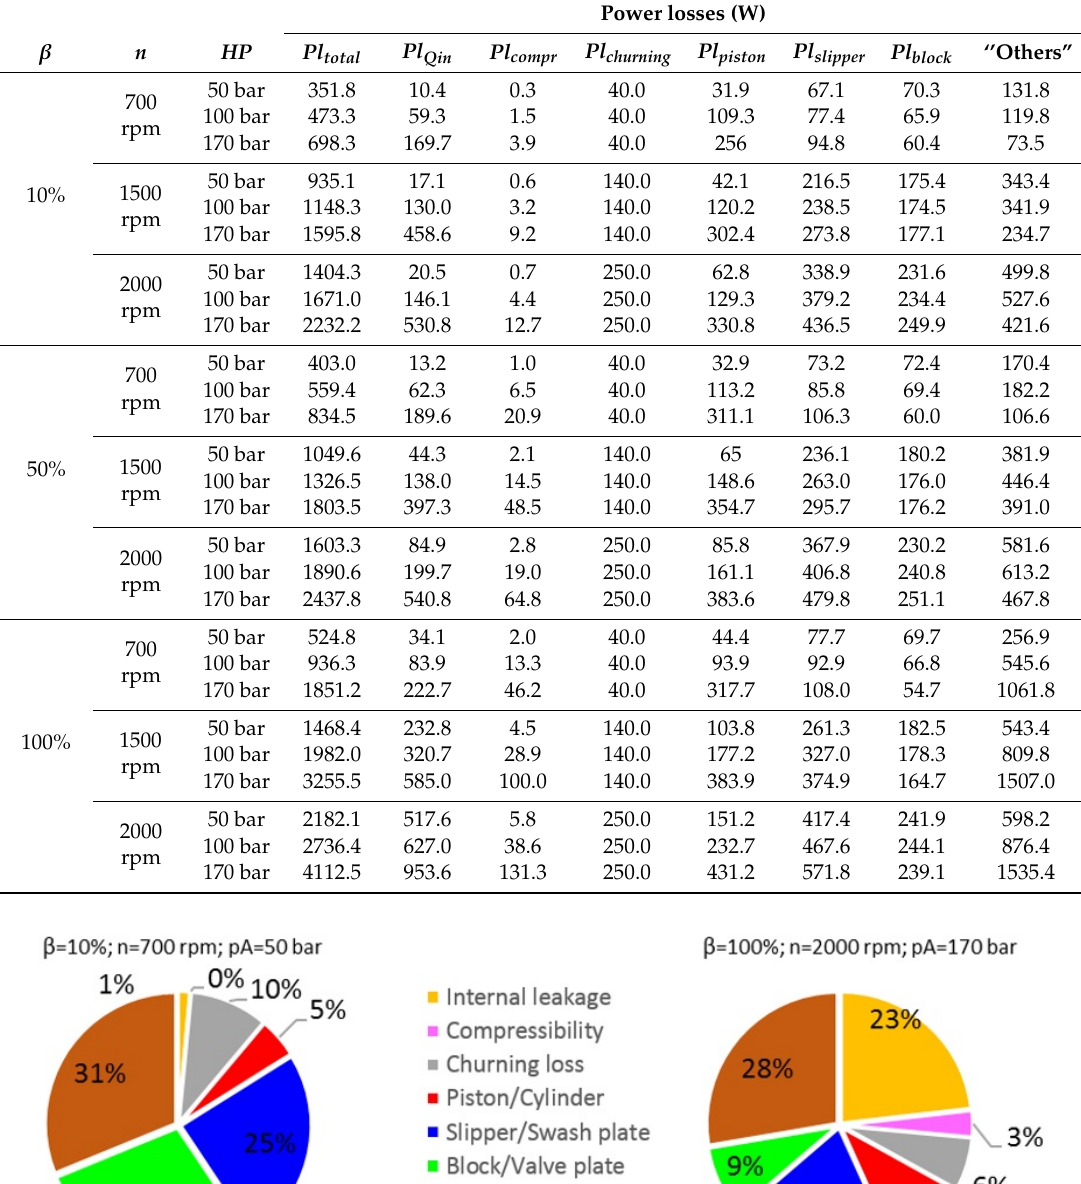
Table 6. Distribution of power losses in the S-APP a 52 cc size; θ B = 70 ◦ C. Power losses (W)